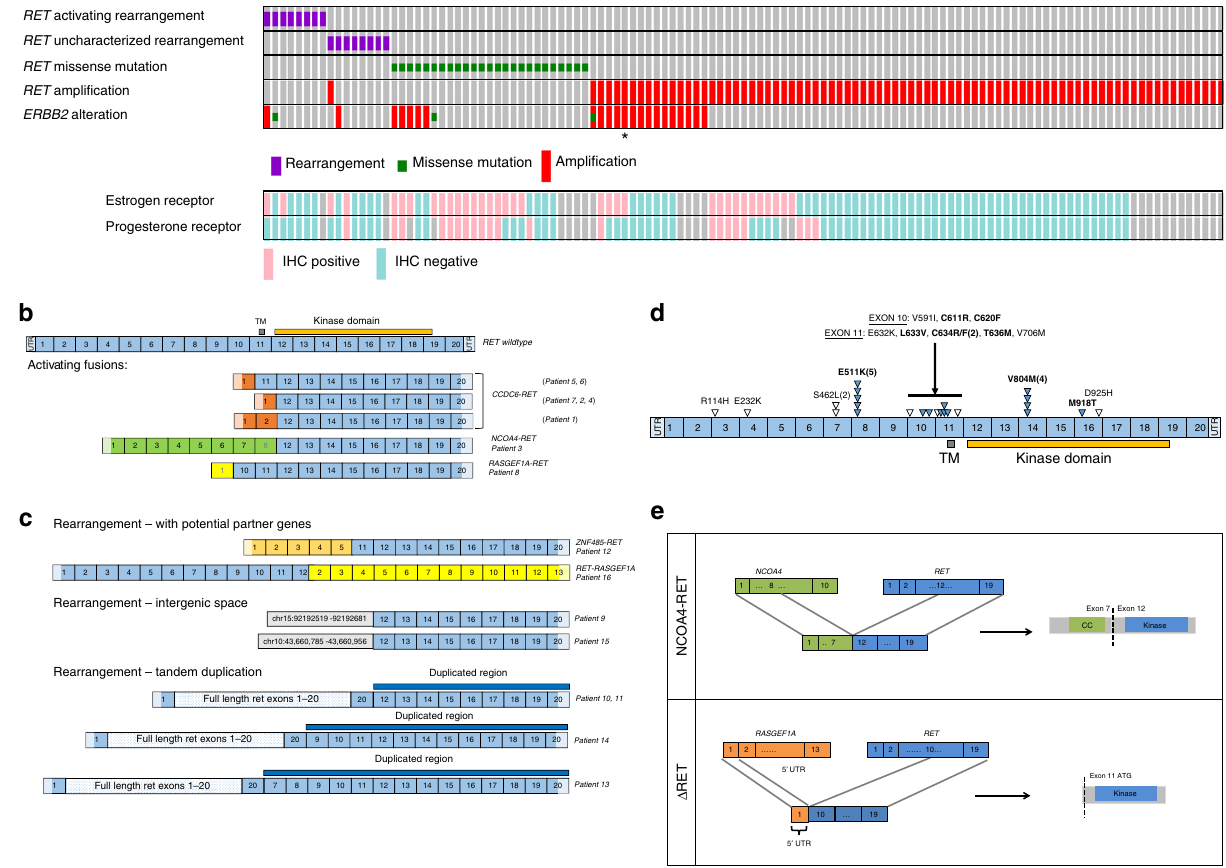
Fig. 1 Recurrent RET rearrangements in breast cancer. a OncoPrint of RET alterations in breast cancer. A case-by-case comparison of 121 breast cancers (column) carrying either a RET activating or uncharacterized rearrangement, missense mutation, or ampli fi cation (rows) to their ERBB2 ampli fi cation status (row) by clinical genomic pro fi ling and available ER (Estrogen Receptor), PR (Progesterone Receptor) status (rows) from routine immunohistochemistry, generated using the oncoprint software 58,59 . Only one case harbored both a RET rearrangement and a RET ampli fi cation. *RET protein expression in tissue from case with RET ampli fi cation is veri fi ed by western blot (Supplementary Fig. 4c). b RET fusions. Exon composition comparing full-length, wild-type RET with activating fusions identi fi ed in this study. Activating fusions maintain the exons (12 – 19) required for an intact kinase domain. Six patient samples carried the CCDC6-RET fusion. NCOA4-RET and a novel RASGEF1A-RET fusion initially detected in the index cases are functionally characterized in